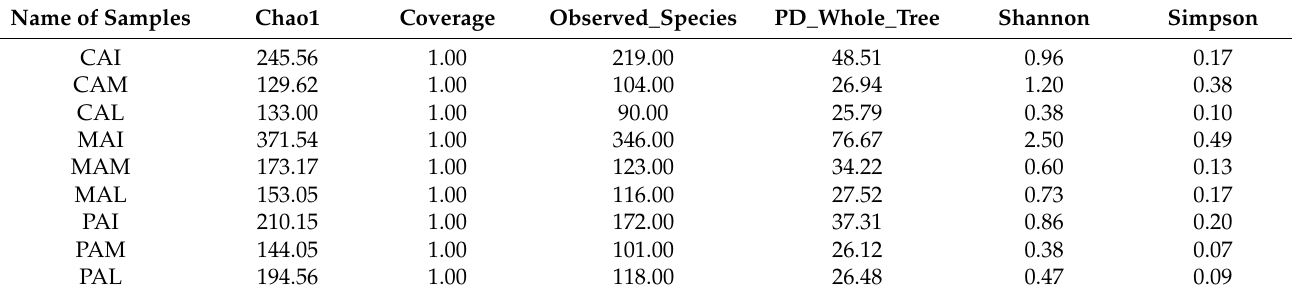
Table 2. Statistical table of Alpha Diversity Index of